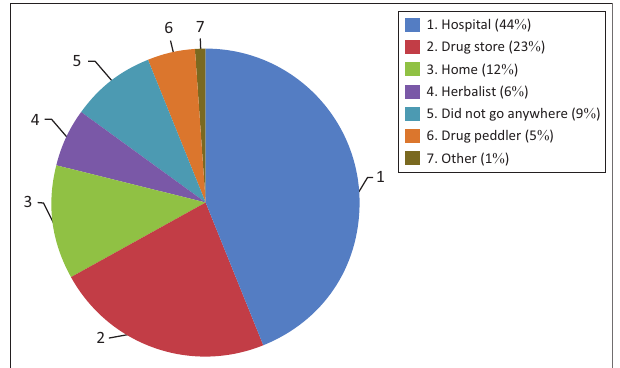
FIGURE 2: First point of call for help for an eye disease.